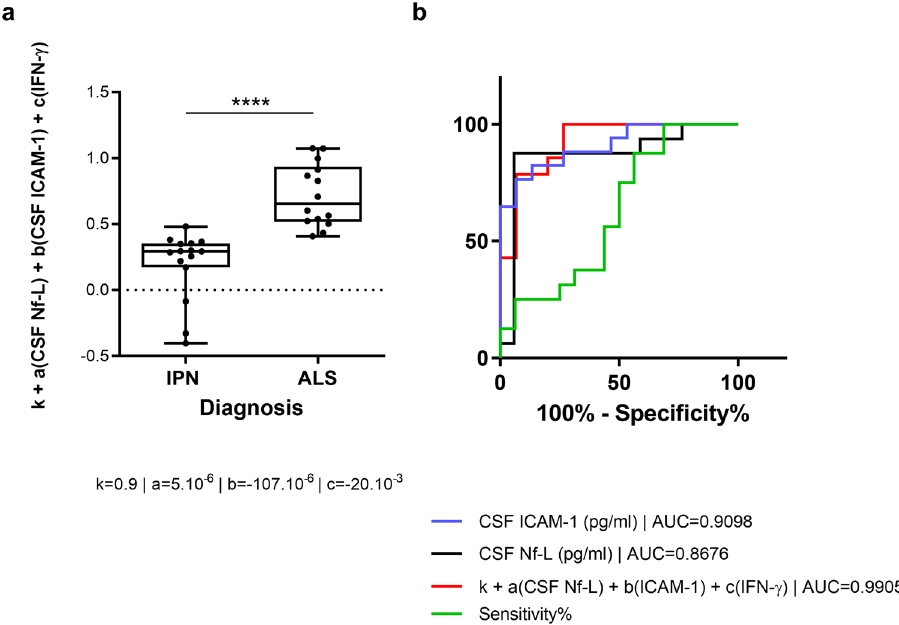
Figure 5. Combination of CSF Nf-L and inflammatory markers as diagnosis biomarker. Diagnosis predictive value of the combination of Nf-L and ICAM-1 CSF levels and IFN-γ serum levels ( a ). ROC Curve analysis CSF Nf-L (black), CSF ICAM-1 (blue), serum IFN-γ (green) and combination the three markers (red) in IPN versus ALS groups ( b